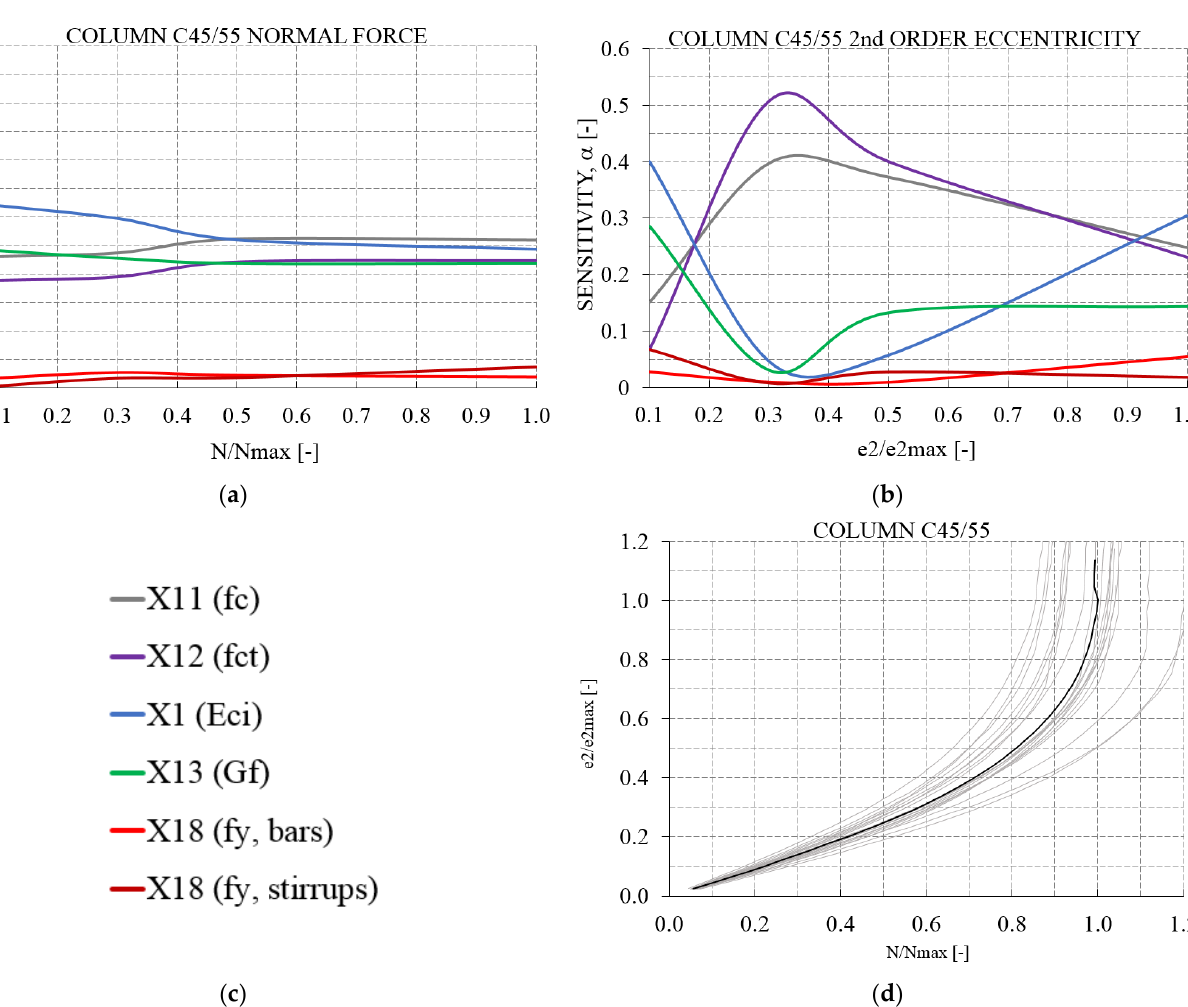
Figure 9. Sensitivity analyses at the component/column level based on the probabilistic non-linear analysis of the considered column made of C45/55, see Section 4.4: ( a ) sensitivity of material parameters with respect to the normalized applied axial force; ( b ) sensitivity of material parameters with respect to the normalized horizontal displacement at middle height of the column; ( c ) basic variables of considered material models; ( d ) normalized horizontal displacement vs. normalized axial force.